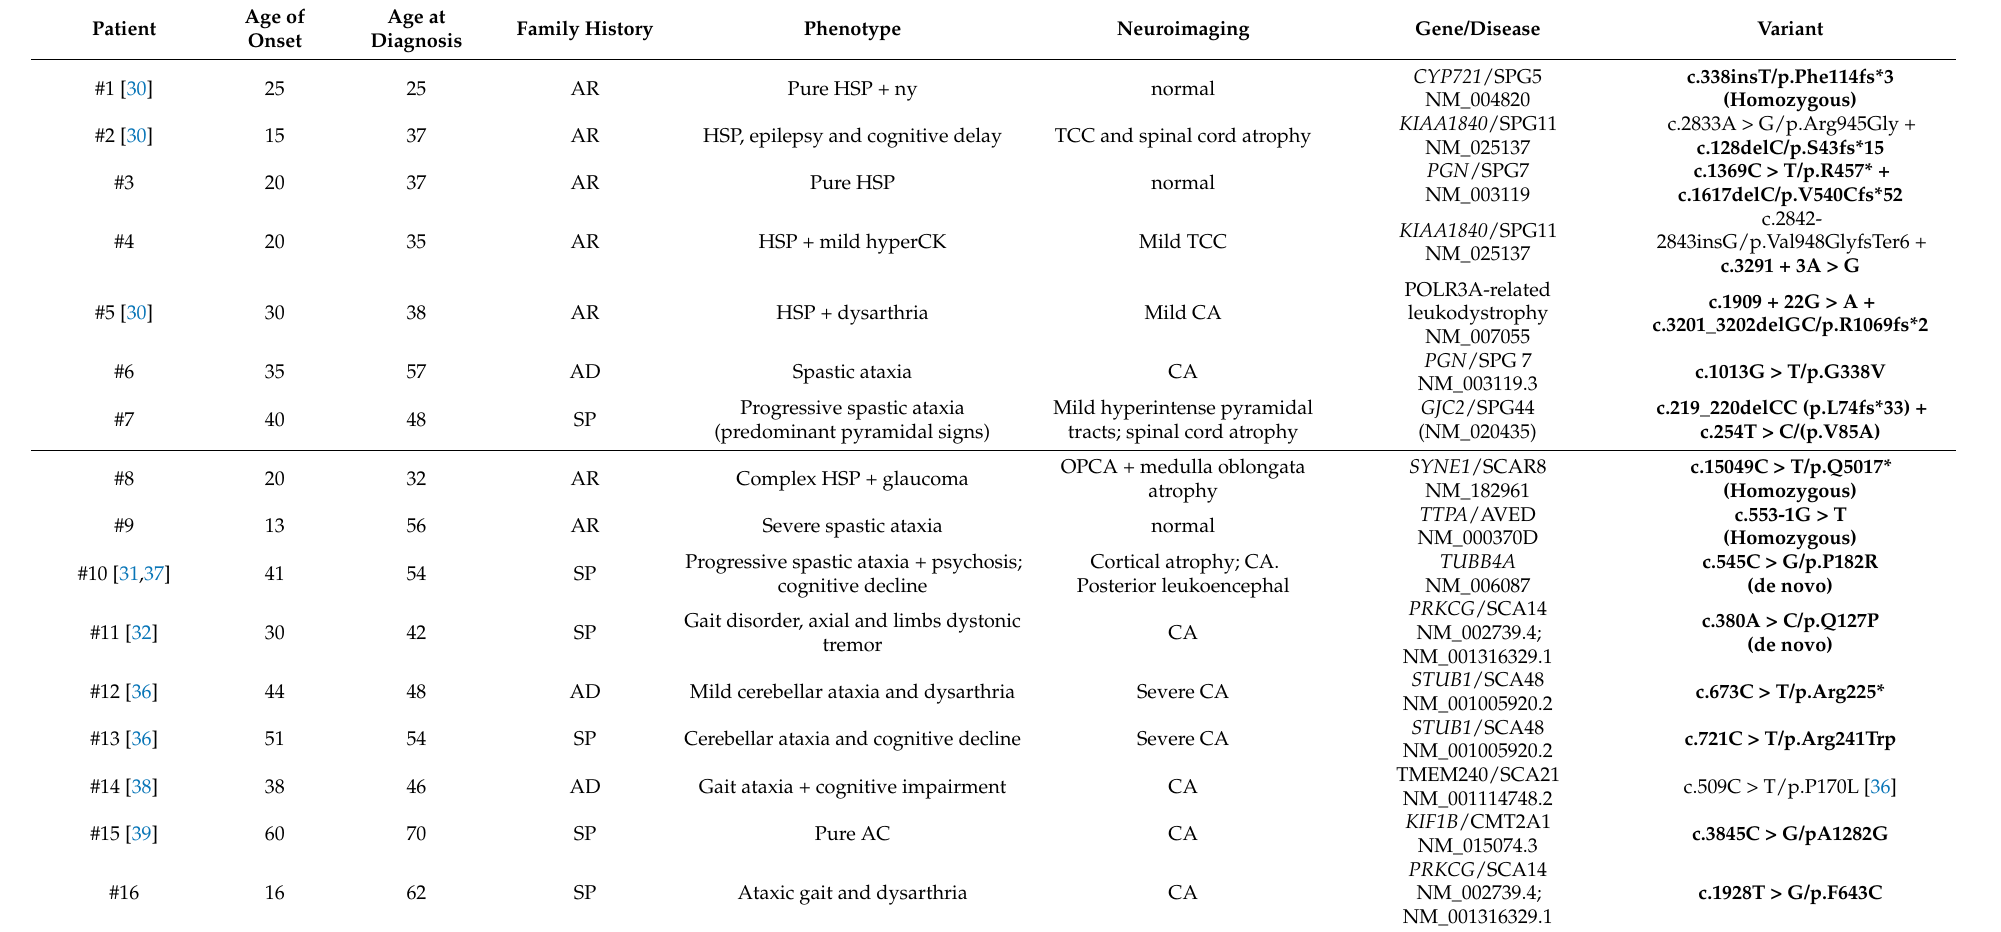
Table 2. Demographic data and clinical/diagnostic findings in HSP and SCA patients successfully assessed by NGS targeted gene panels. Novel variants are reported in bold. AR: autosomal recessive; AD: autosomal dominant; SP: sporadic; TCC: thin corpus callosum; CA: cerebellar atrophy OPCA: Olivo-ponto-cerebellar atrophy; POLR3A: Polymerase RNA III. Related references are reported in brackets. The line in bold divides HSP and ataxias